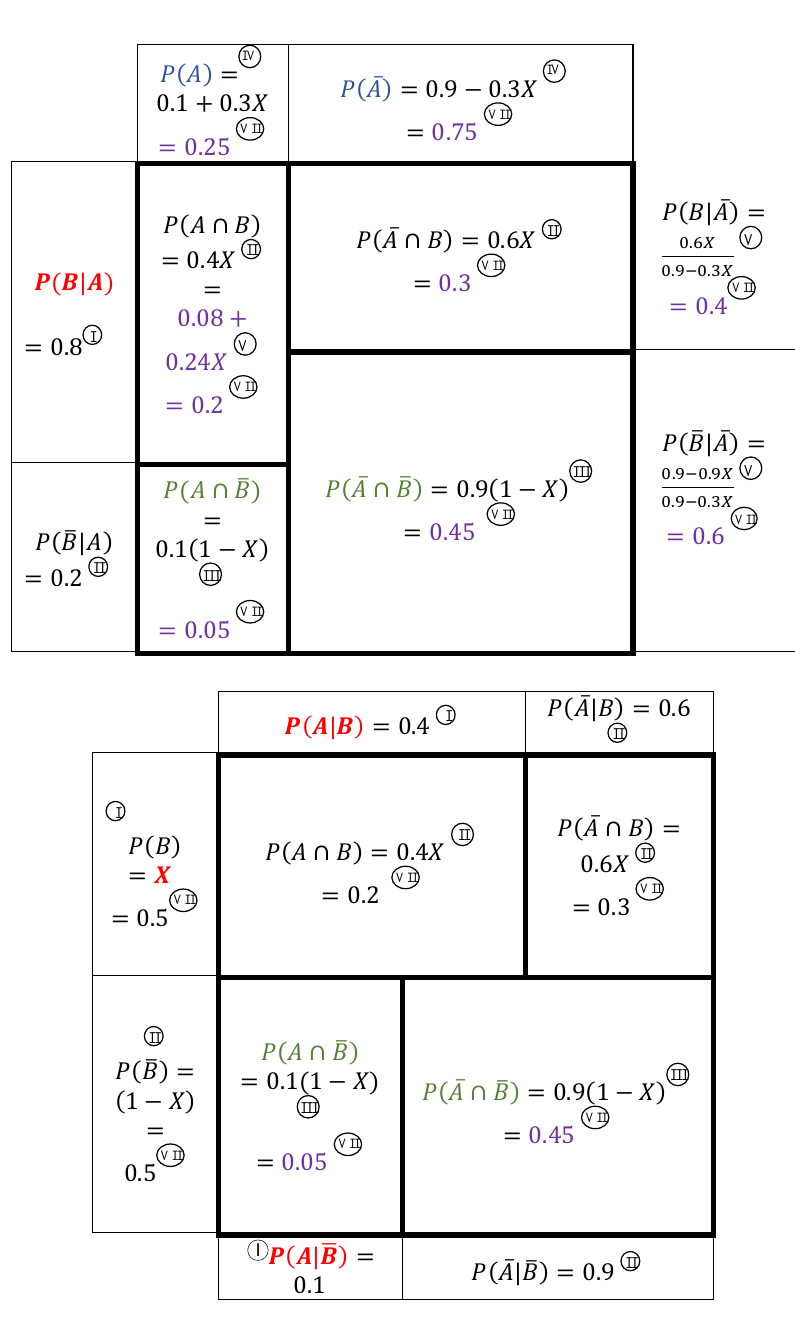
Figure 9. Algebraic solution of a ternary problem of conditional probability given the three known values 𝑃(𝐵|𝐴) = 0.8 , 𝑃(𝐴|𝐵) = 0.4 , and 𝑃(𝐴|𝐵̅) = 0.1 . Since these values are split between the two diagrams,